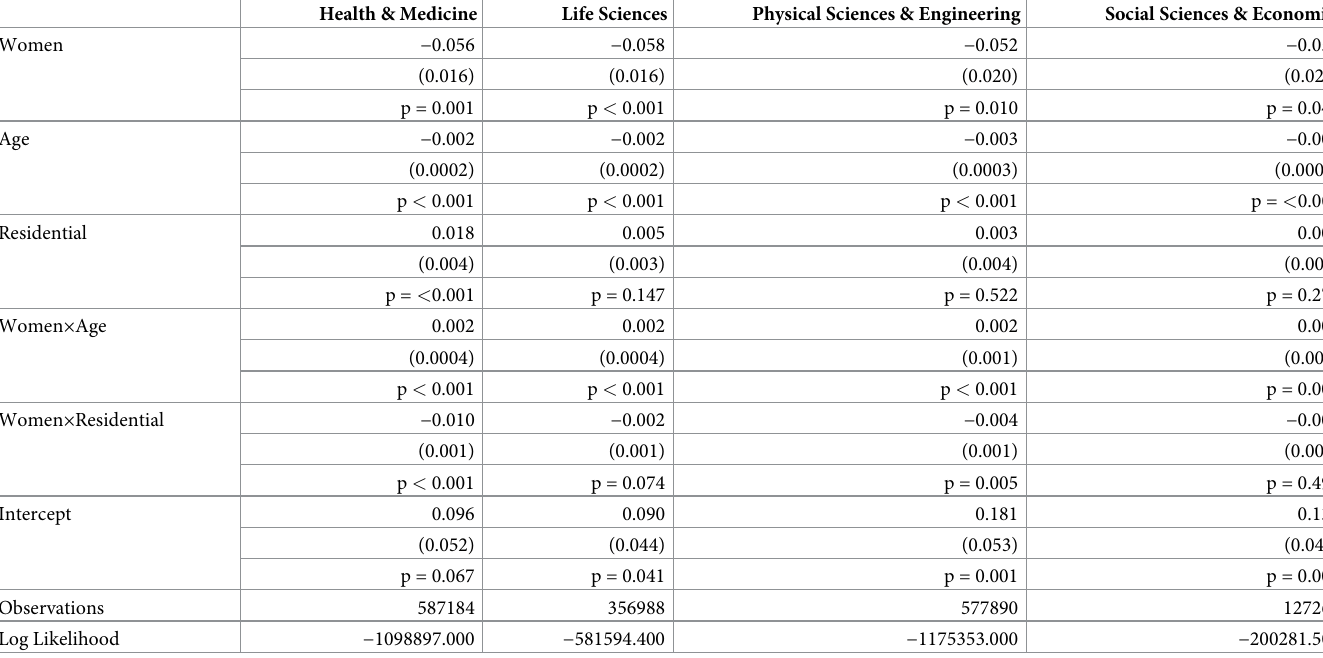
Table 4. Mixed effects models predicting February-May 2020 changes in the number of submissions per area of research.